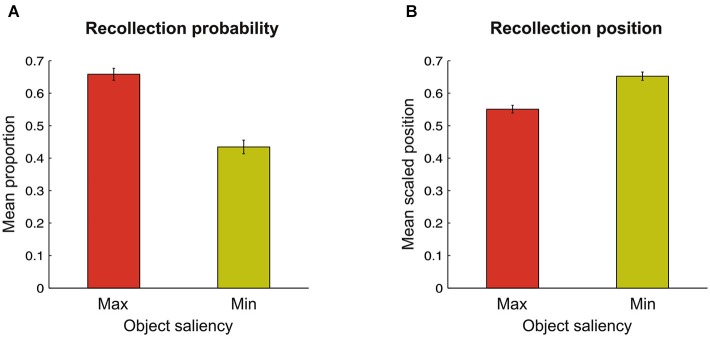
(A) Bar graph showing a higher probability to recollect objects corresponding at the location of maximal (red bar) as compared to minimal (yellow bar) saliency in the scene. (B) Average position in the streams of recollected objects, indicating that objects corresponding at locations of maximal saliency were reported earlier than objects at minimal saliency. In both graphs, the error bars represents the standard error of the mean.